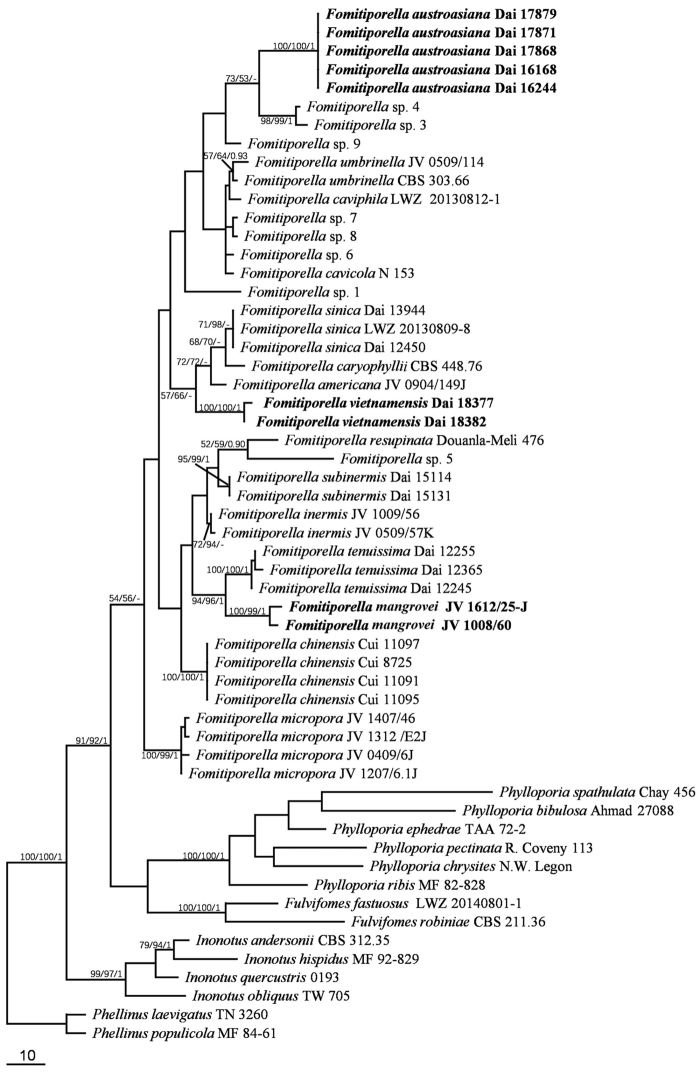
Phylogeny of Fomitiporella inferred from the 28S dataset. The topology is that of the MP analysis, and statistical values (ML/MP/BI) are indicated for each node that simultaneously received BS from ML and MP not below 50 %, and BPP from BI not below 0.9. Phellinus
laevigatus and P.
populicola are used to root the tree. Branch lengths reflect the number of steps as indicated by the scale.